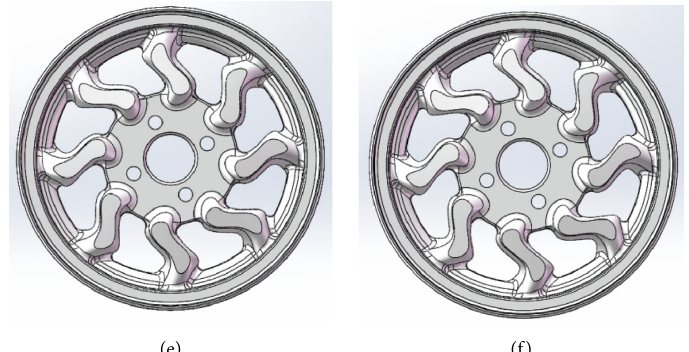
Figure 12: Different wheel structures. (a) Wheel a. (b) Wheel b. (c) Wheel c. (d) Wheel d. (e) Wheel e. (f) Wheel f.